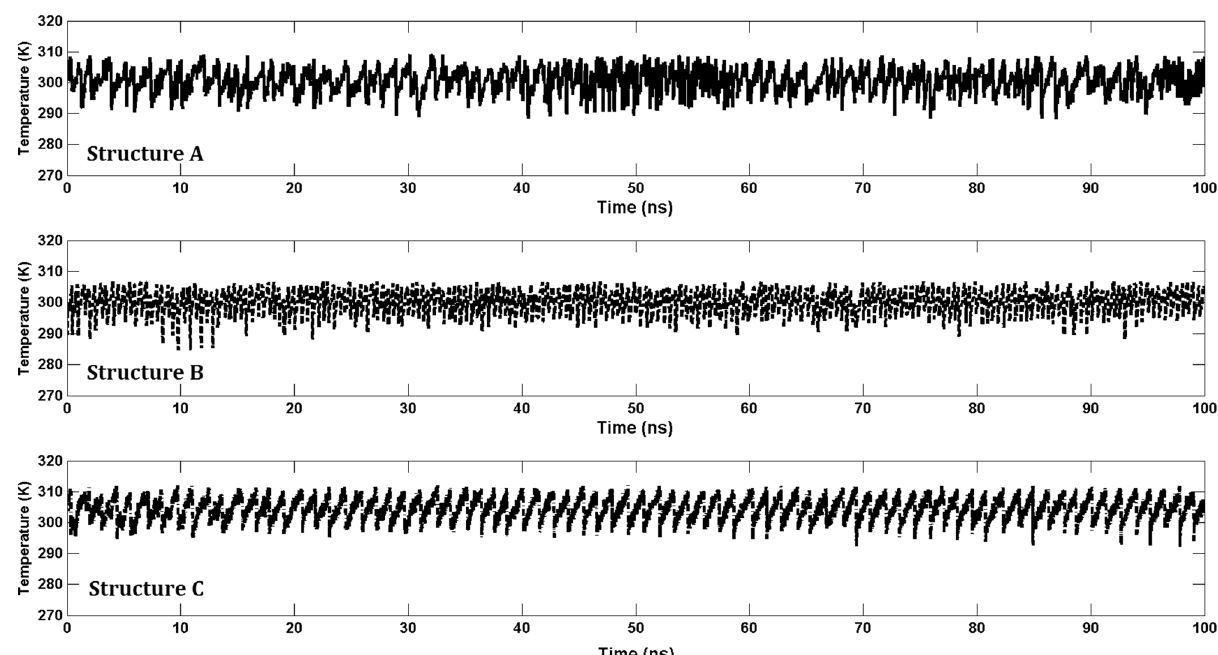
Figure 10. Fluctuation of the temperature in the three structures with various